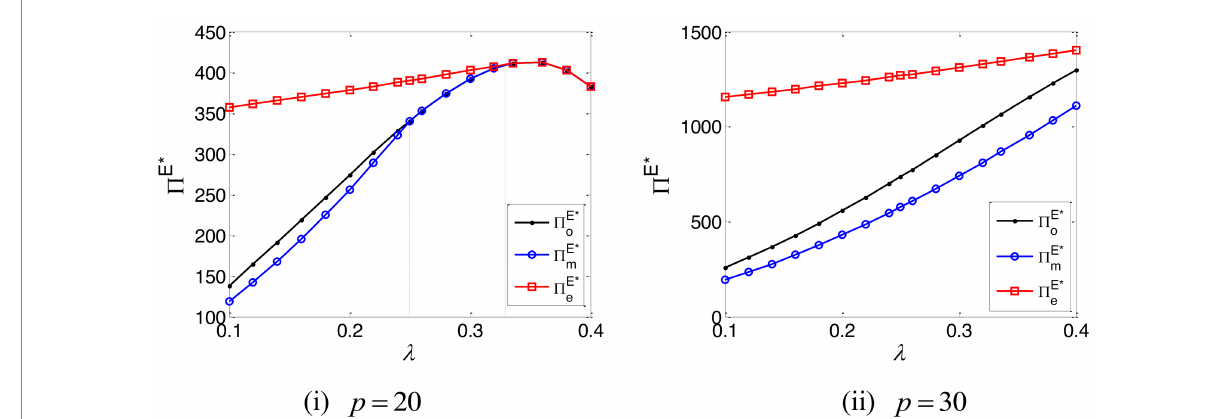
FIGURE 6 The profit of the e-commerce platform.